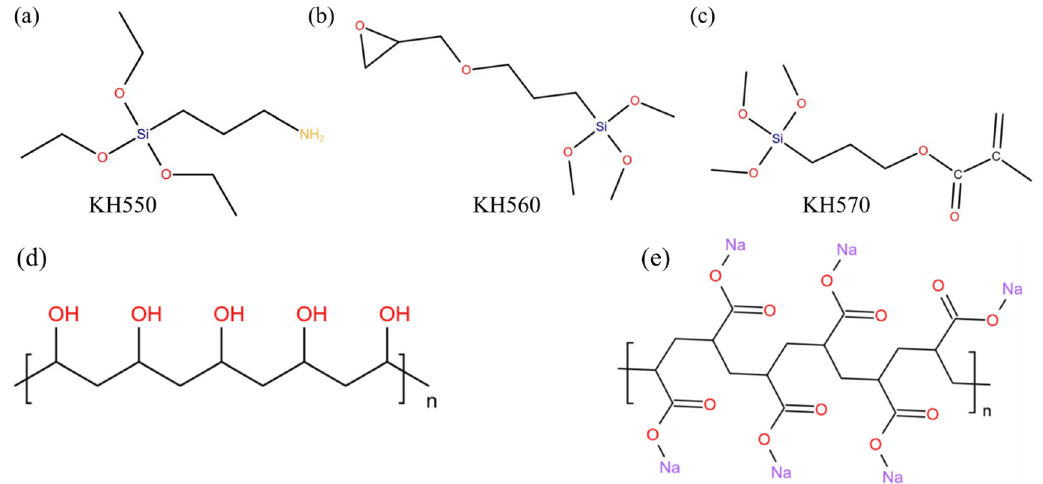
Figure 1. Molecular structure of ( a ) KH550; ( b ) KH560; ( c ) KH570; ( d ) PVA; ( e ) PAA ‐ Na.